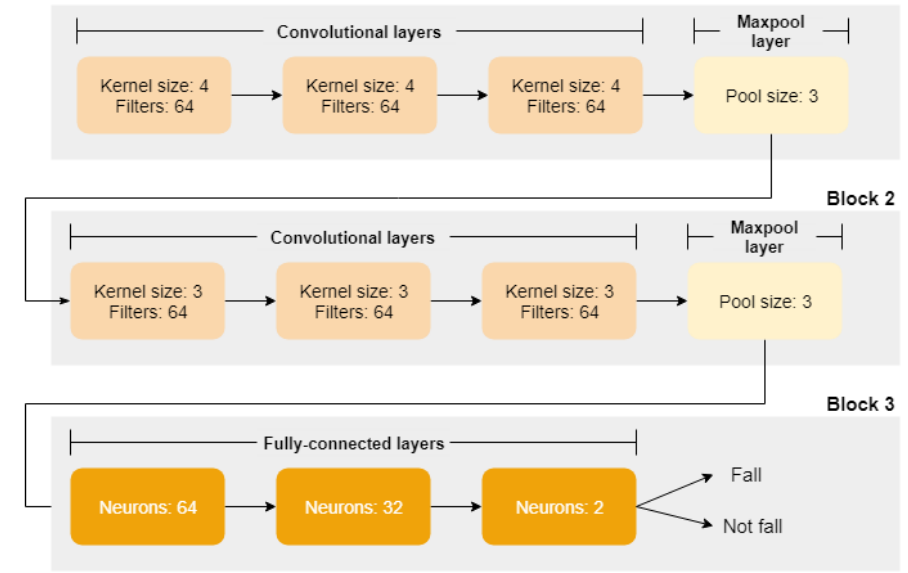
Figure 4. CNN-3B3Conv model to detect fall from accelerometer